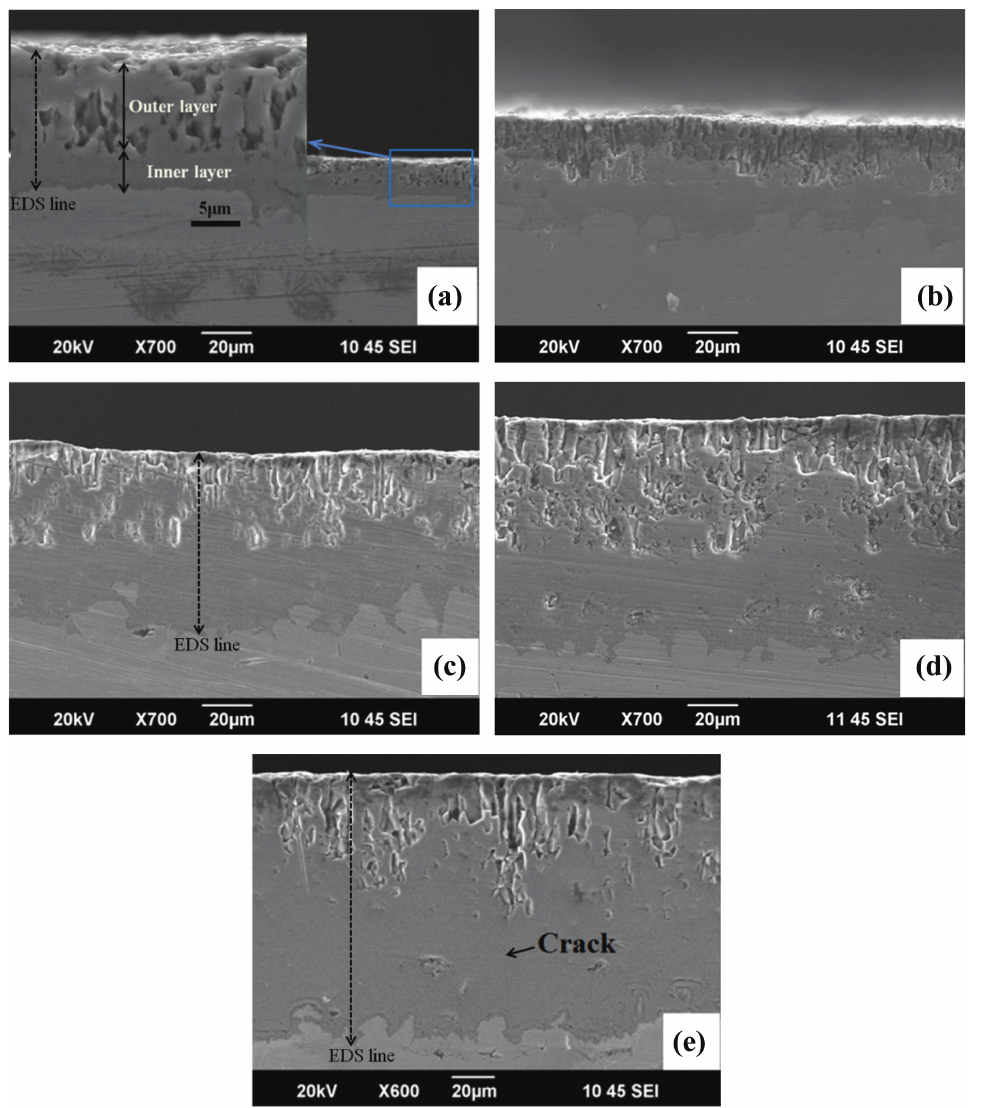
Figure 6: The cross-sectional images of the oxides exposure to SCW at 620°C and 25 MPa for 10, 80, 200, 600 and 1000 h, respectively. (a) 10 h, (b) 80 h, (c) 200 h, (d) 600 h and (e) 1000